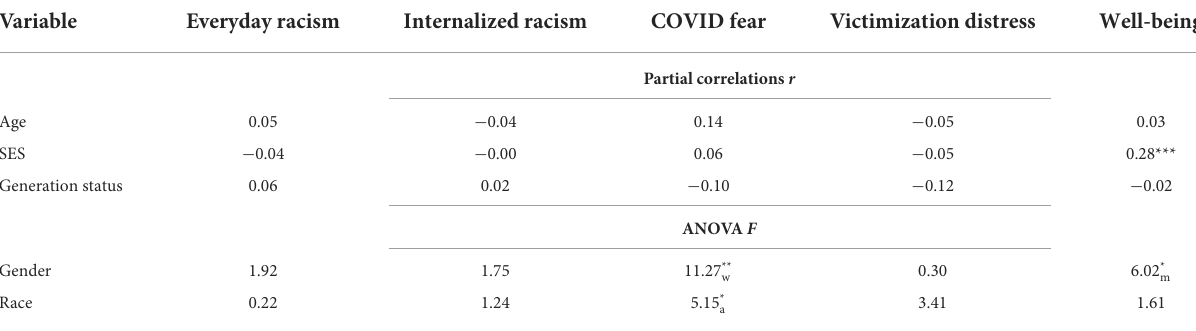
TABLE 6 Correlations and ANOVA results for demographics and study variables for study 2 controlling for everyday racism before the pandemic.